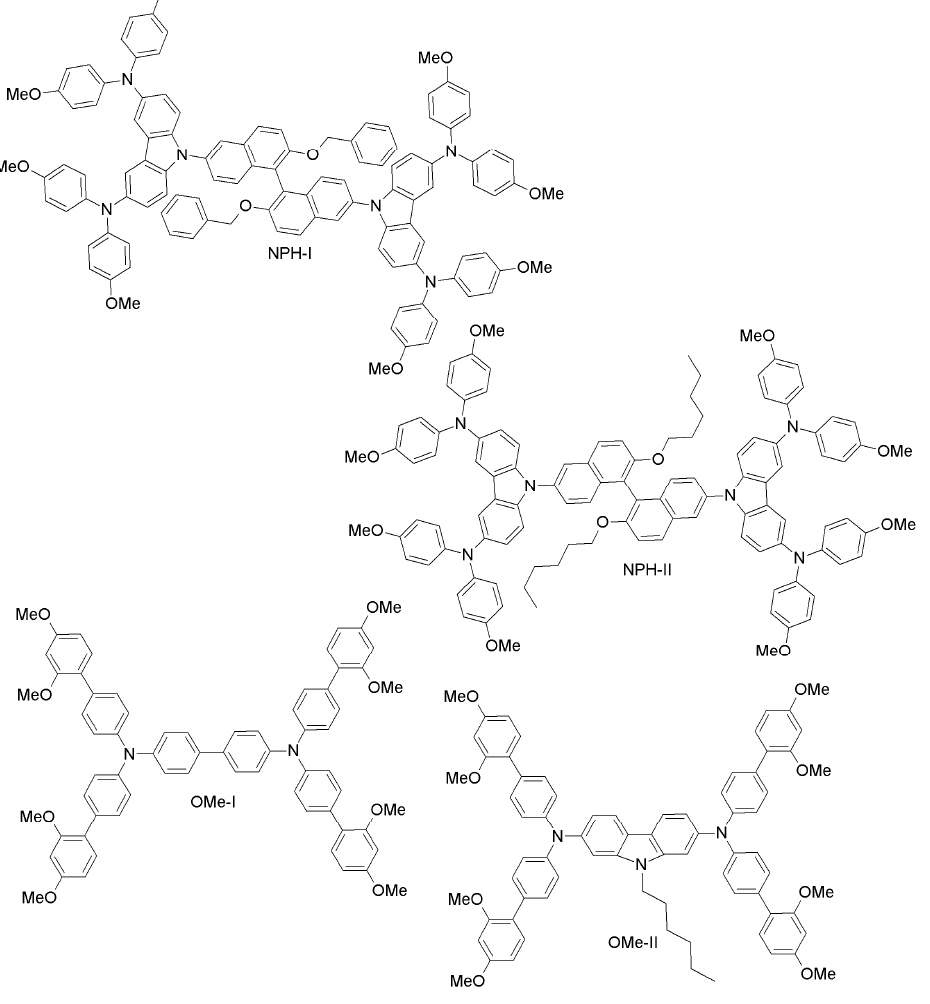
Figure 18. Other organic HTMs.